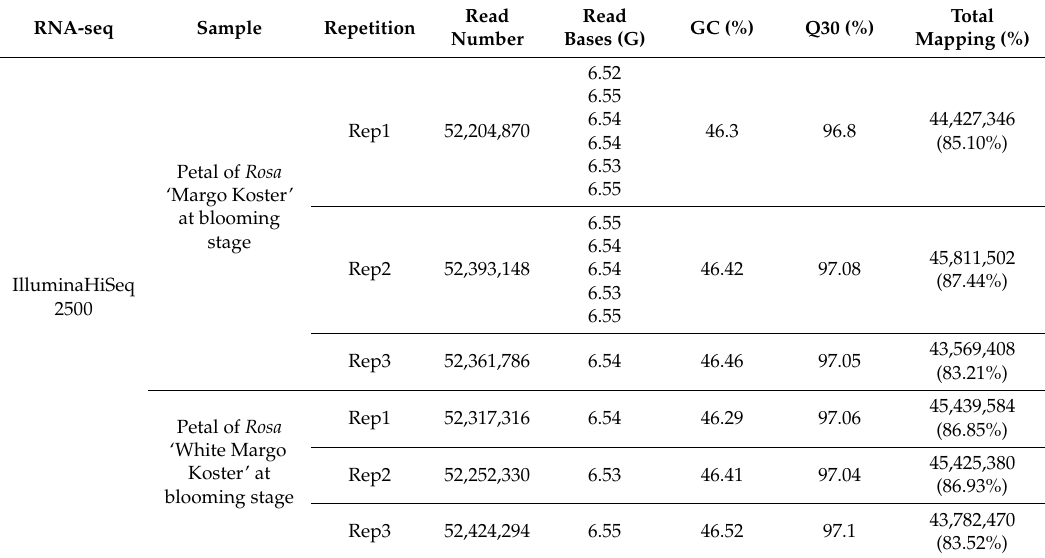
Table 2. Summary of sequencing data from Illumina platform.